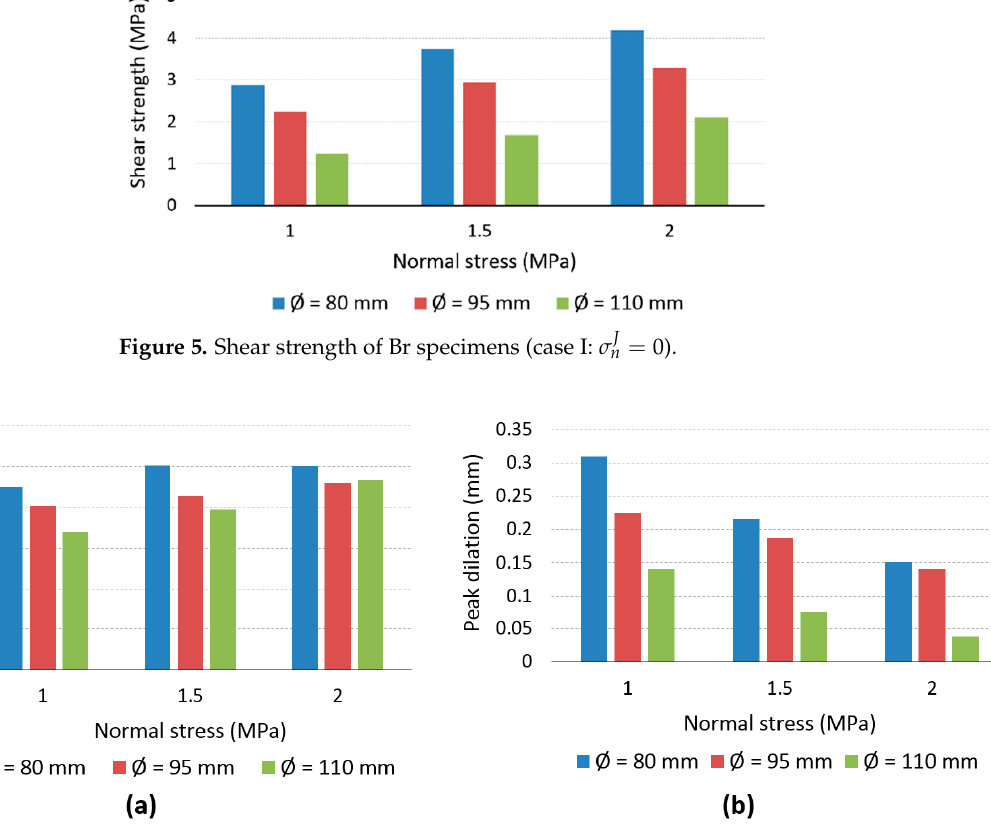
Figure 6. ( a ) Peak shear displacement and ( b ) peak dilation values for Br specimens subjected to direct shear test condition (case I: 𝜎 (cid:3041)(cid:3011) = 0 ).